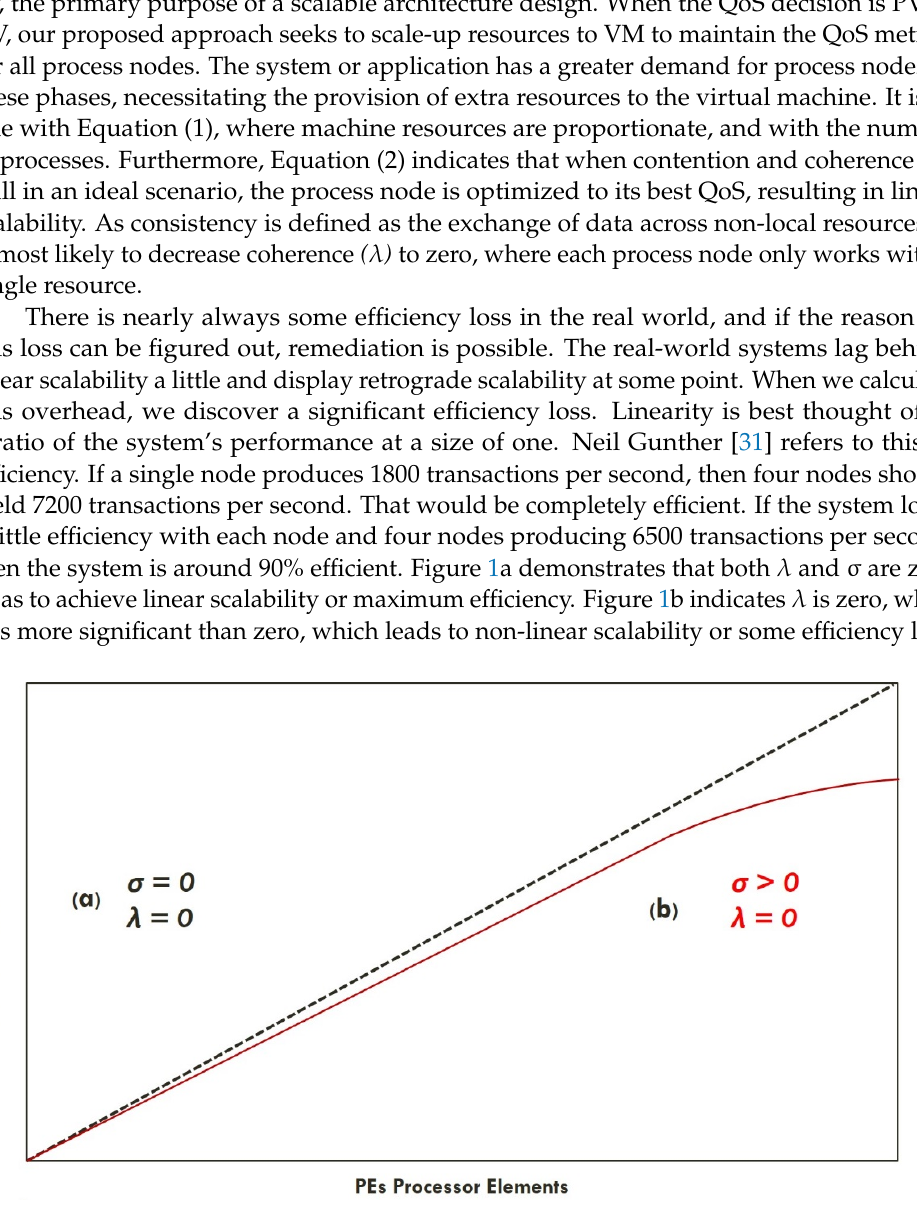
Figure 1. Scalability performance for throughput: ( a ) linear scalability; ( b ) non-linear scalability.